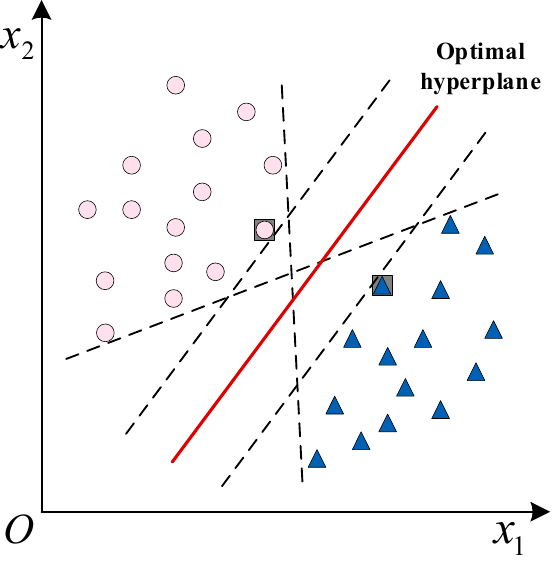
Figure 11. Support vectors in two-dimensional space.